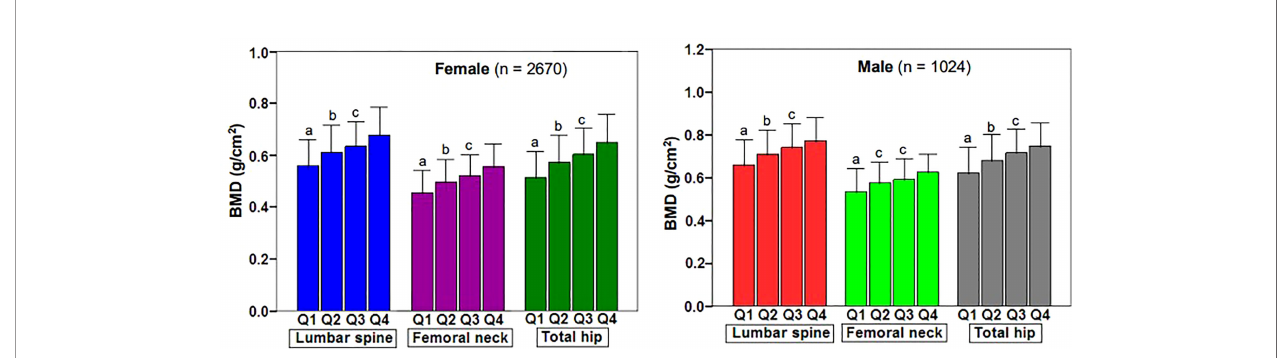
FIGURE 2 | Changes of BMD at various skeletal sites in body surface area offracture patients strati fi ed by quartile. BMD, bone mineral density; Q1, fi rst quartile; Q2, second quartile; Q3, third quartile; Q4, fourth quartile; LS, lumbar spine (L1 – L4); FN, femoral neck; TH, total hip. a P < 0.001 compared with Q2, Q3 and Q4. b P = 0.001 to < 0.001 compared with Q3 and Q4. c P = 0.003 to < 0.001 compared with